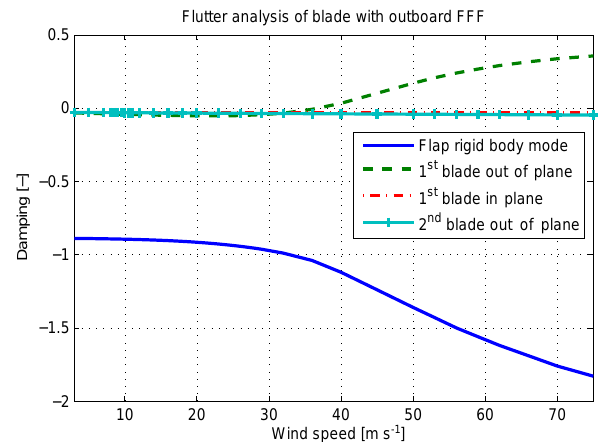
Figure 9. Variation in modal damping with total incident air